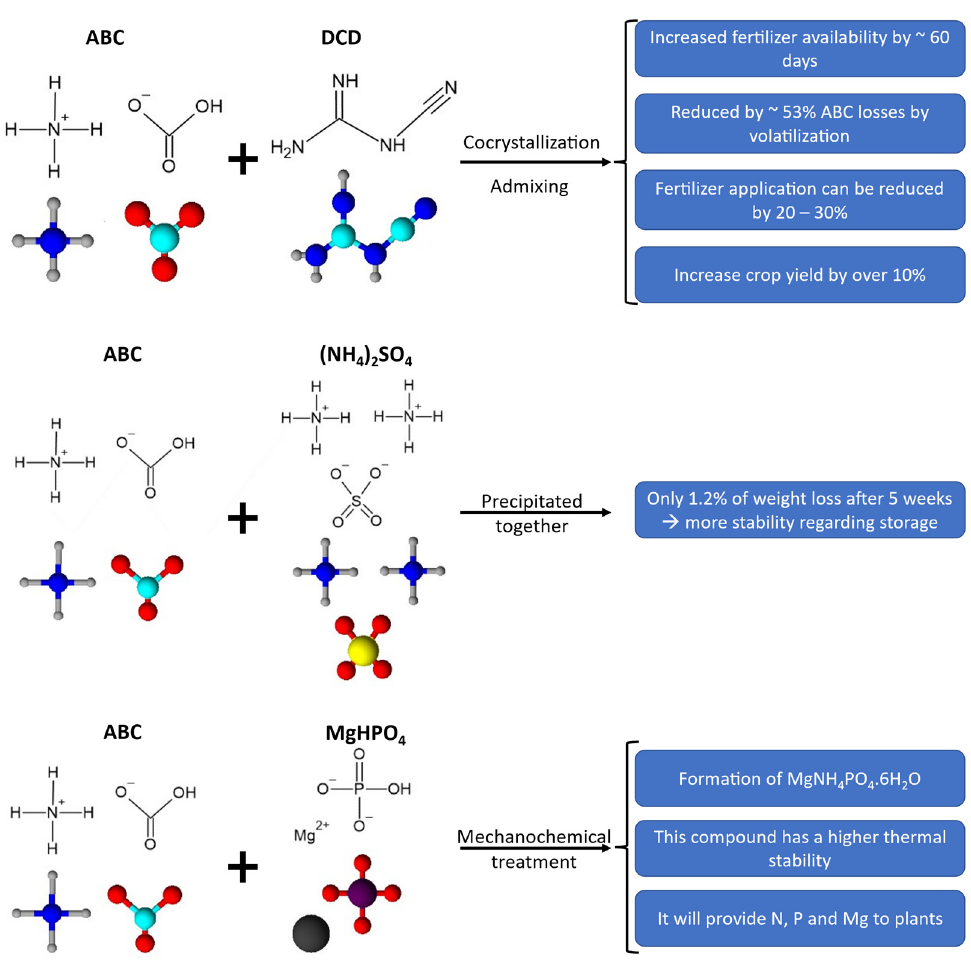
Figure 5. Ammonium bicarbonate reactions with other substances to form more stable compounds. Compiled from [50–52,59].